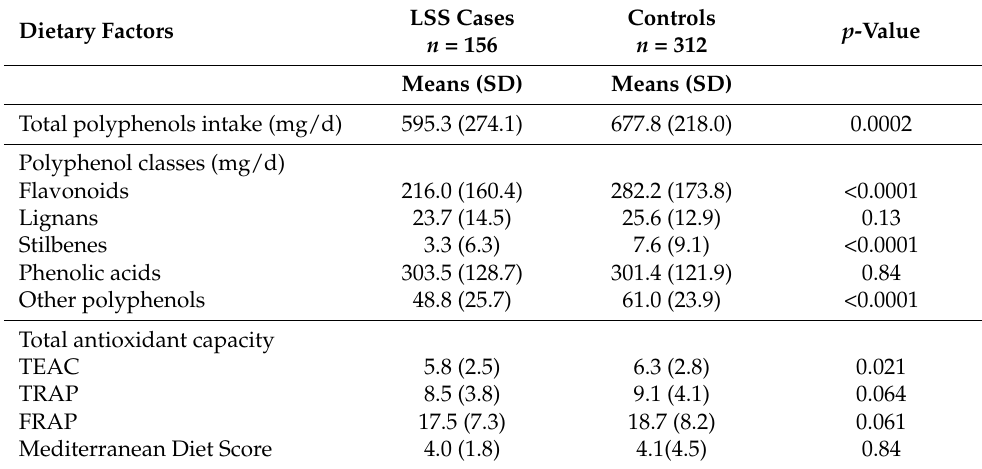
Table 2. Dietary factors in Lumbar Spinal Stenosis (LSS) cases and matched controls.